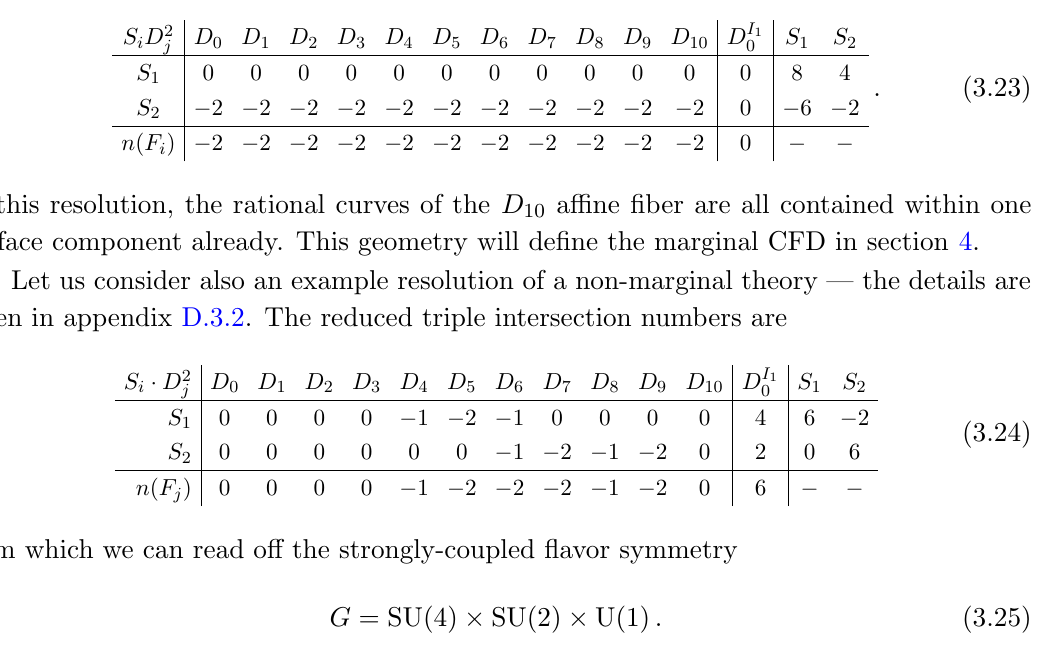
to trivially satisfy the split condition of the 6